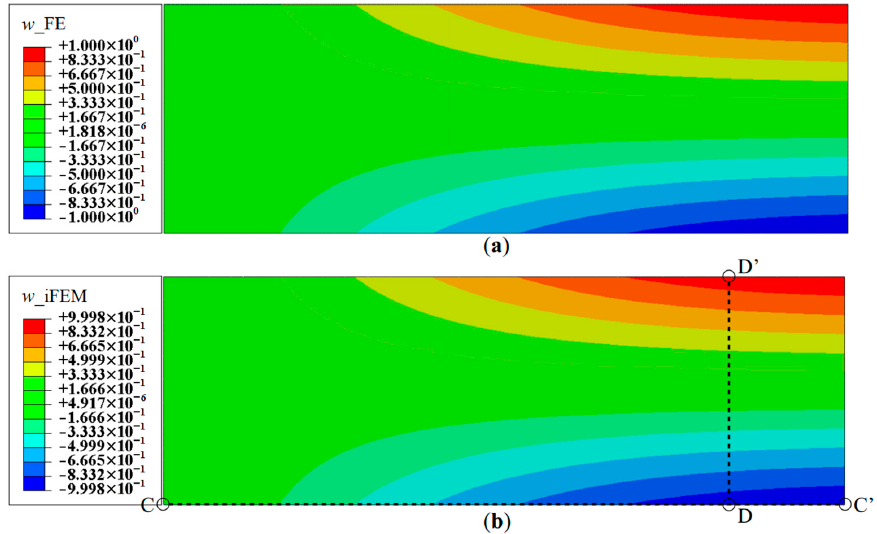
Figure 8. Contour plots of deflection for Mode 2: ( a ) FE results; and ( b ) iFEM results using full-field strain data (Configuration D).